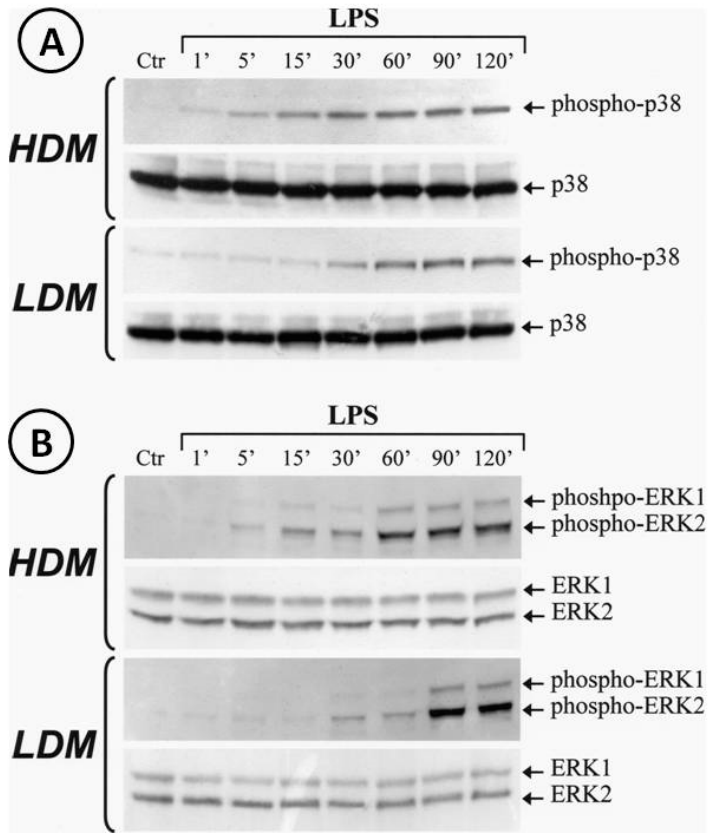
Figure 8. Kinetics of phosphorylation of p38 and ERK1/2 induced by LPS in LDMs and HDMs. Cells were stimulated with LPS (1 µg/mL) for the times indicated. Reactions were stopped by addition of ice-cold PIPES buffer. Cell pellets were microfuged, lysed and subjected to Western blot analysis with anti-phosphorylated-p38 ( Panel A , gels 1 and 3) or anti-phosphorylated-ERK1/2 ( Panel B , gel 1 and 3) Abs as described in Materials and Methods. Membranes were then stripped and reblotted with anti-p38 ( Panel A , gel 2 and 4) or anti-ERK1/2 ( Panel B , gels 2 and 4) Abs to verify equal protein content in each sample. The Western blot shown is representative of three separate experiments.